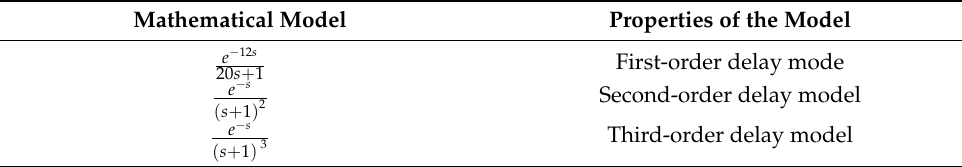
Table 1. Control object